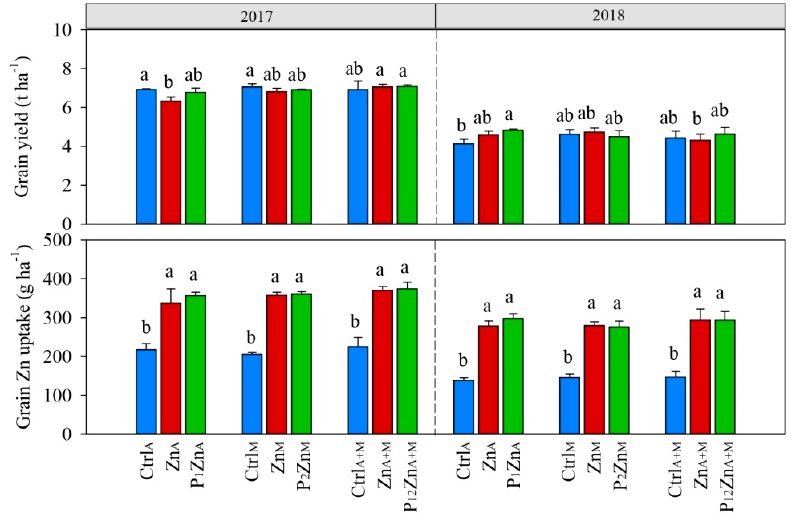
Figure 2. The grain yield and grain Zn uptake in wheat plants harvested in 2017 and 2018. Treatments consisted of nil Zn spray (control, Ctrl) and foliar Zn application alone (Zn) or plus pesticides (PZn) at the anthesis (A), milk stage (M) or both (A + M). Pesticides were a mixture of fungicide + insecticide which were thiophanate-methyl + beta-cypermethrin at anthesis (P 1 Zn A ) and triadimefon + imidacloprid at milk stage (P 2 Zn M ). Vertical bars represent the standard error of four replications. Columns with no letter in common indicate significant di ff erences between treatments each year by least significant di ff erence (LSD) test ( p < 0.05).